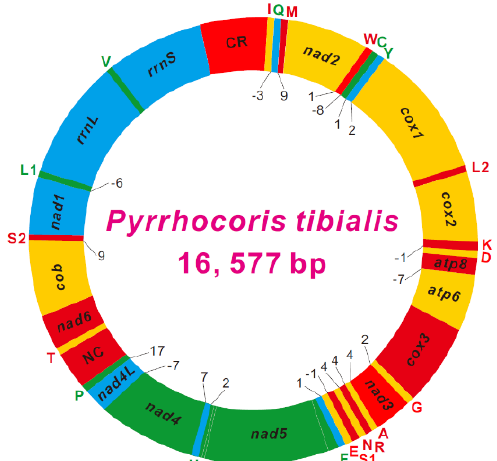
Figure 1. Circular map of the mitochondrial genome of Pyrrhocoris tibialis . Protein coding and ribosomal genes are shown with standard abbreviations. Genes for transfer RNAs (tRNAs) are abbreviated by a single letter, with S1 = AGN, S2 = UCN, L1 = CUN, and L2 = UUR. Genes coded in the J (H)-strand (clockwise orientation) are red-colored or orange-colored. Genes coded in the N (L)-strand (counter-clockwise orientation) are green-colored or cyan-colored. Numbers at gene junctions indicate the length of small non-coding regions where negative numbers indicate an overlap between genes.